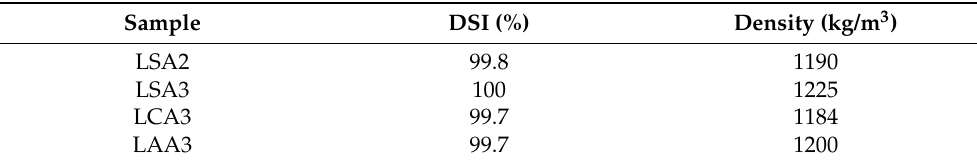
Table 2. DSI and Density measurement of the lignin